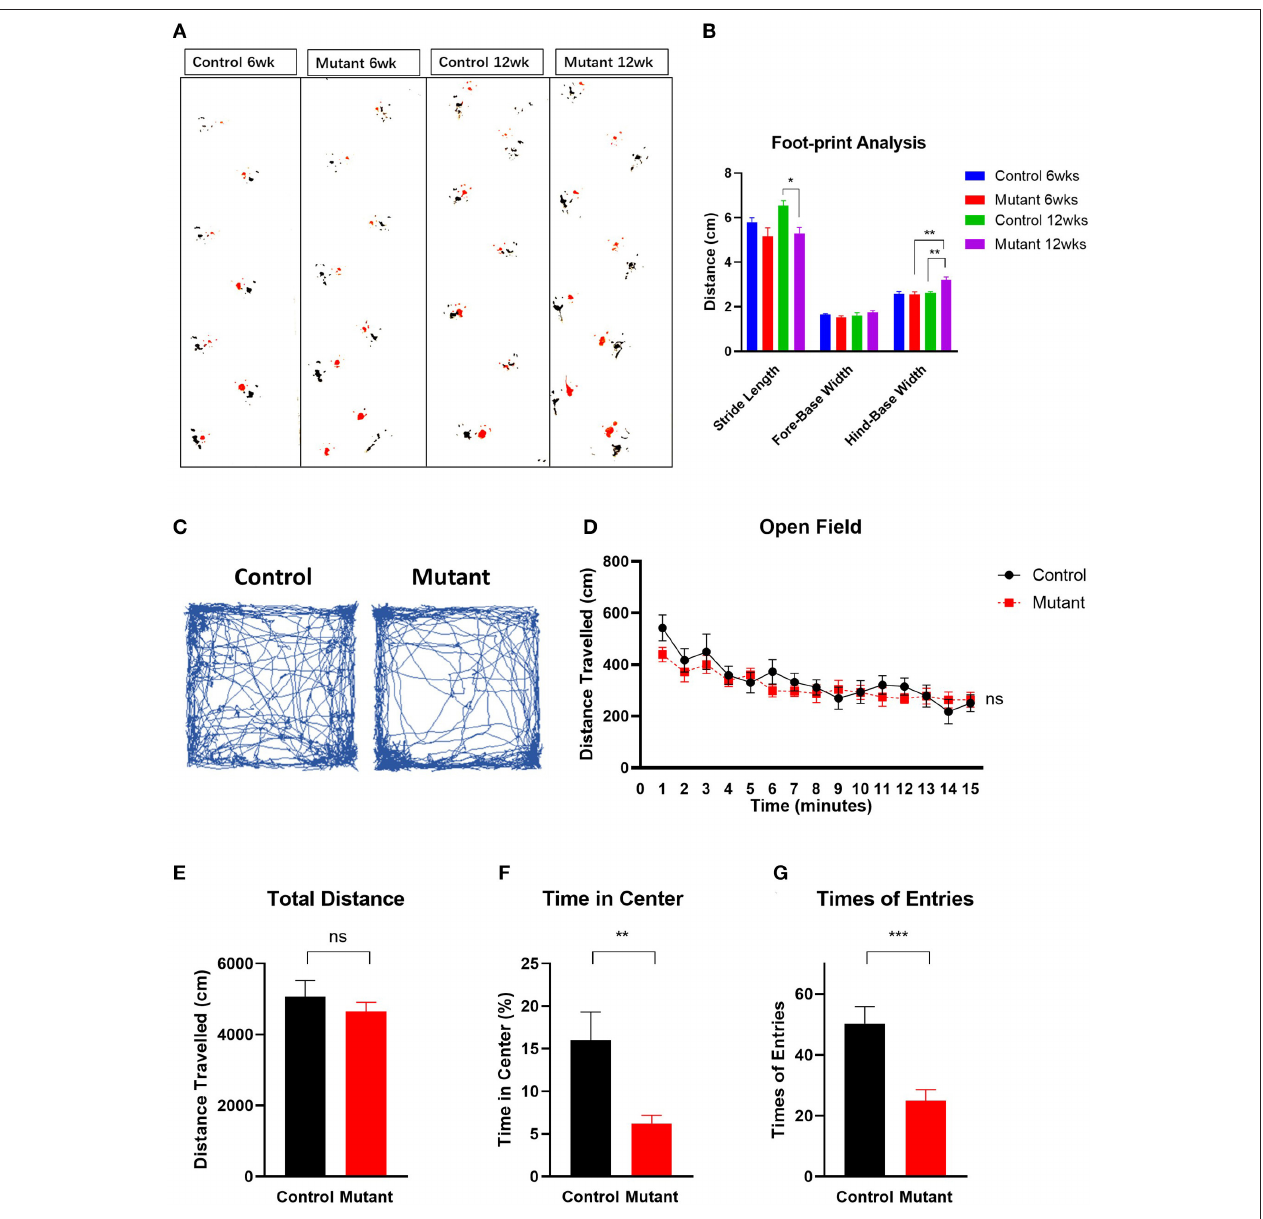
FIGURE 3 | Motor coordination impairment and locomotor activity in PC Scn8a mutant mice. (A) Representative walking footprint patterns. (B) Gait footprint analysis at 6 and 12 weeks was evaluated for stride length, fore-base width and hind-base width. Mutant mice displayed ataxic gait with reduced stride length and increased stride width at 12 weeks of age ( n > 6 per group. * P < 0.05, ** P < 0.01; *** P < 0.001, two-way ANOVA, Bonferroni’s post-hoc analysis). (C) Representative traces of mouse activity in an open field during a 15-min recording time. (D) Locomotor activity in the open field was comparable between control ( n = 9) and mutant mice ( n = 11) in a 15min time bin ( P = 0.4223). Time in minutes is shown on the X-axis. (E) The total distance moved in the open field test was not significantly different between controls and mutants ( P > 0.05). (F,G) Mutant mice spent less time (F) in the center of the open field ( P = 0.0063), and entered the center of the open field less often (G) than the controls ( P < 0.001). Data shown are means ± SEM. ns, not significant. * P < 0.05, ** P < 0.01, *** P < 0.001, two-way ANOVA, Bonferroni’s post-hoc analysis for (D) . Student unpaired t -test for (E–G) .